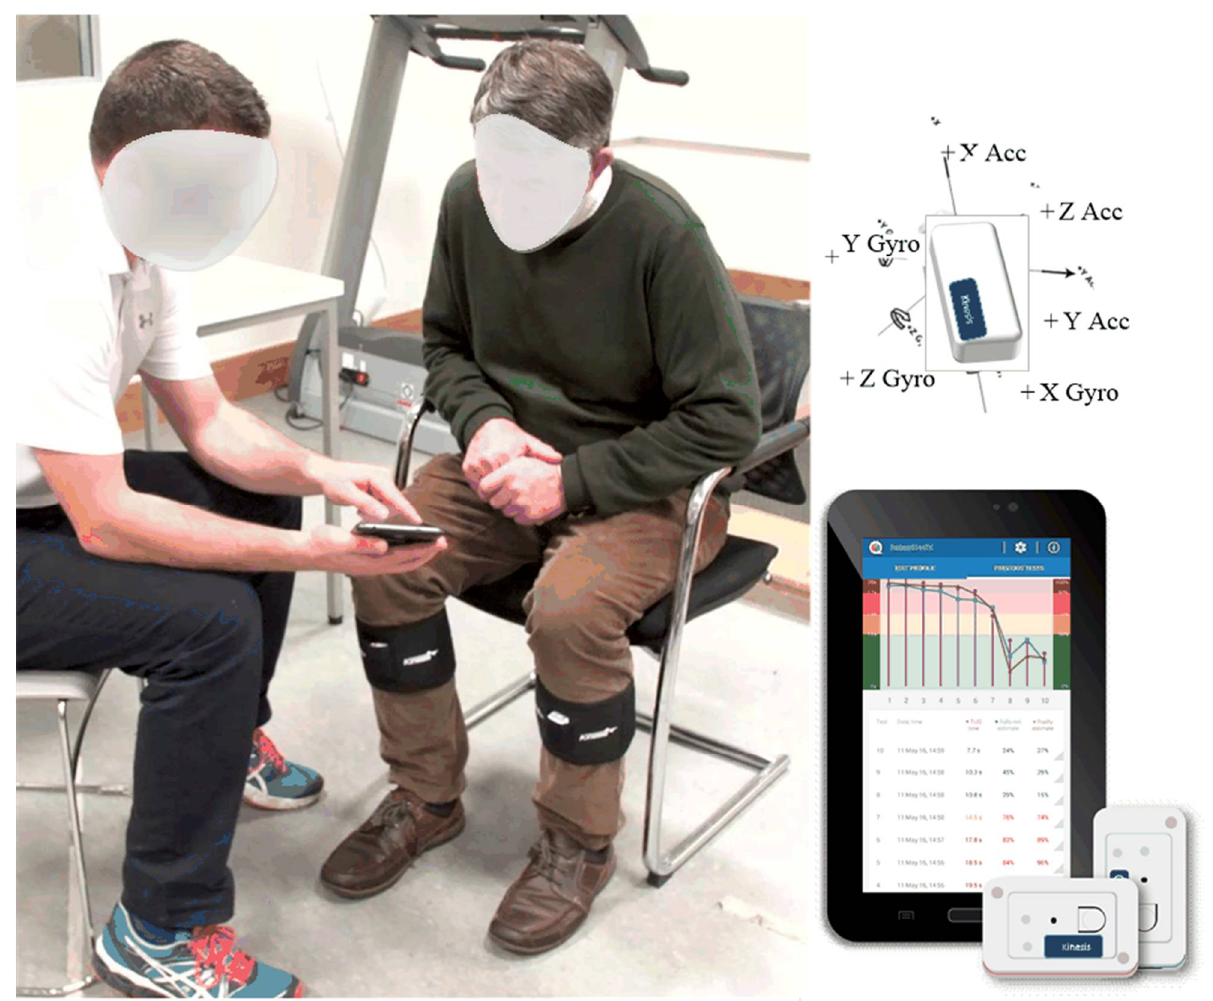
Figure 2. Inertial sensor is placed on the shin using a Velcro strap for each assessment. Sensor data are streamed to a tablet device via Bluetooth. Sensor accelerometer and gyroscope axes are shown. Each QTUG assessment (QTUG™, Kinesis Health Technologies, Dublin, Ireland) produces 71 different calculated parameters, which include a range of features quantifying gait, mobility, turning and transfers [27] (details on the processing applied to produce each parameter are reported elsewhere [38,45]). In addition, each assessment produces a statistical falls risk estimate (FRE sensor ) [38,45] based on the inertial sensor data as well as a statistical Frailty estimate based on the inertial sensor data (FE sensor )